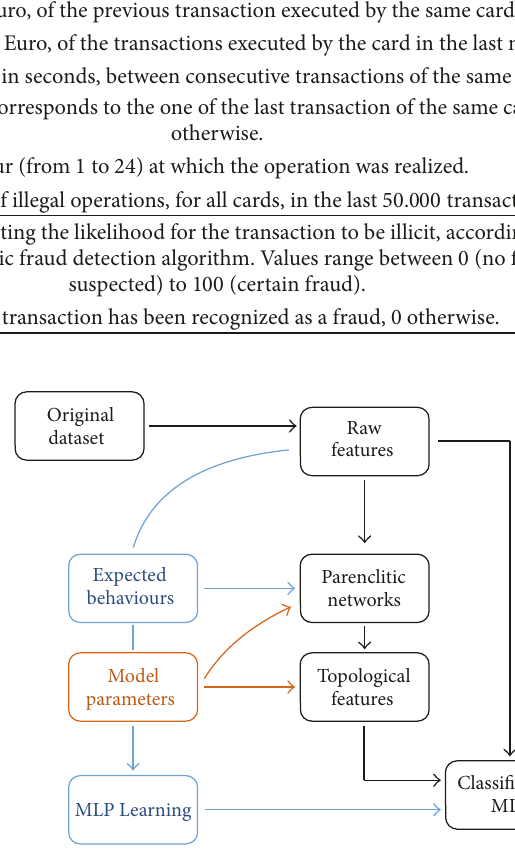
Figure 1: Schematic representation of the classification model. See main text for